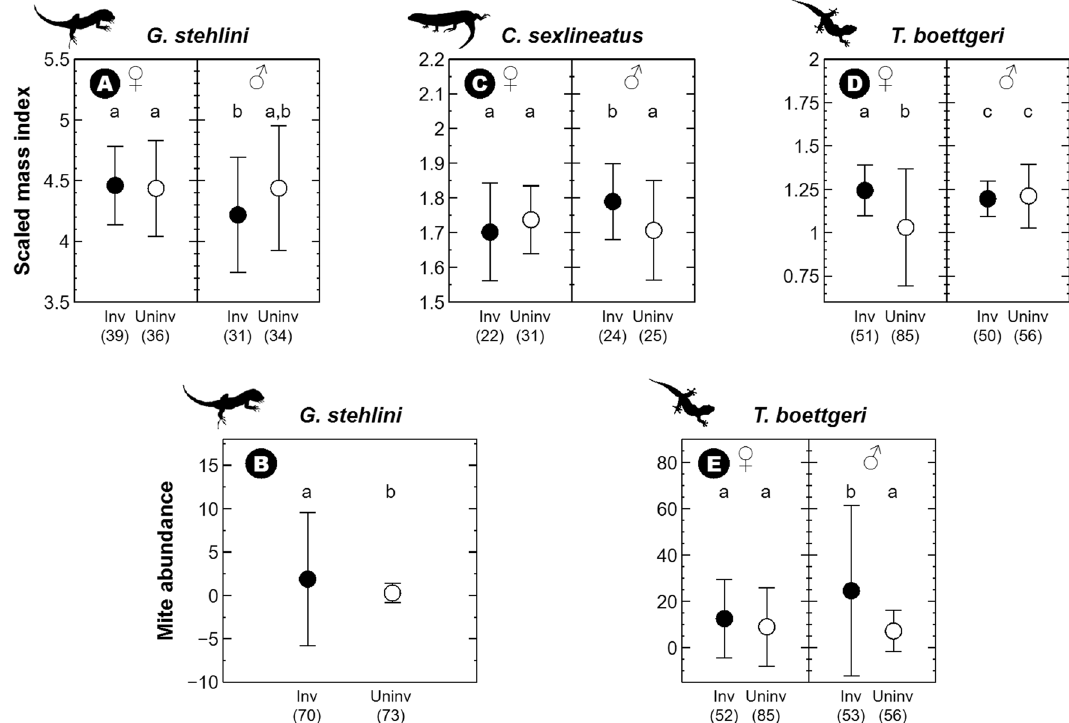
Figure 4. Mean and SD (error bars) of the scaled mass index 53 and mite abundance in adult females ( ♀ ) and males ( ♂ ) of Gran Canaria giant lizards ( Gallotia stehlini ) ( A , B ), Gran Canaria skinks ( Chalcides sexlineatus ) ( C ) and Boettger’s wall geckos ( Tarentola boettgeri ) ( D , E ) in sites invaded (inv; black) and uninvaded (uninv; white) by the California kingsnake ( Lampropeltis californiae ). Sample size for each trait—i.e., number of individuals captured for which each trait was measured, excluding values attributed to observer error—is indicated between parentheses below each figure. Parasite loads are not shown for C. sexlineatus due to the absence of parasites in this species. Significant differences are signaled with different letters. All silhouettes come from phylopic.org or the free repository of the Government of the Canary